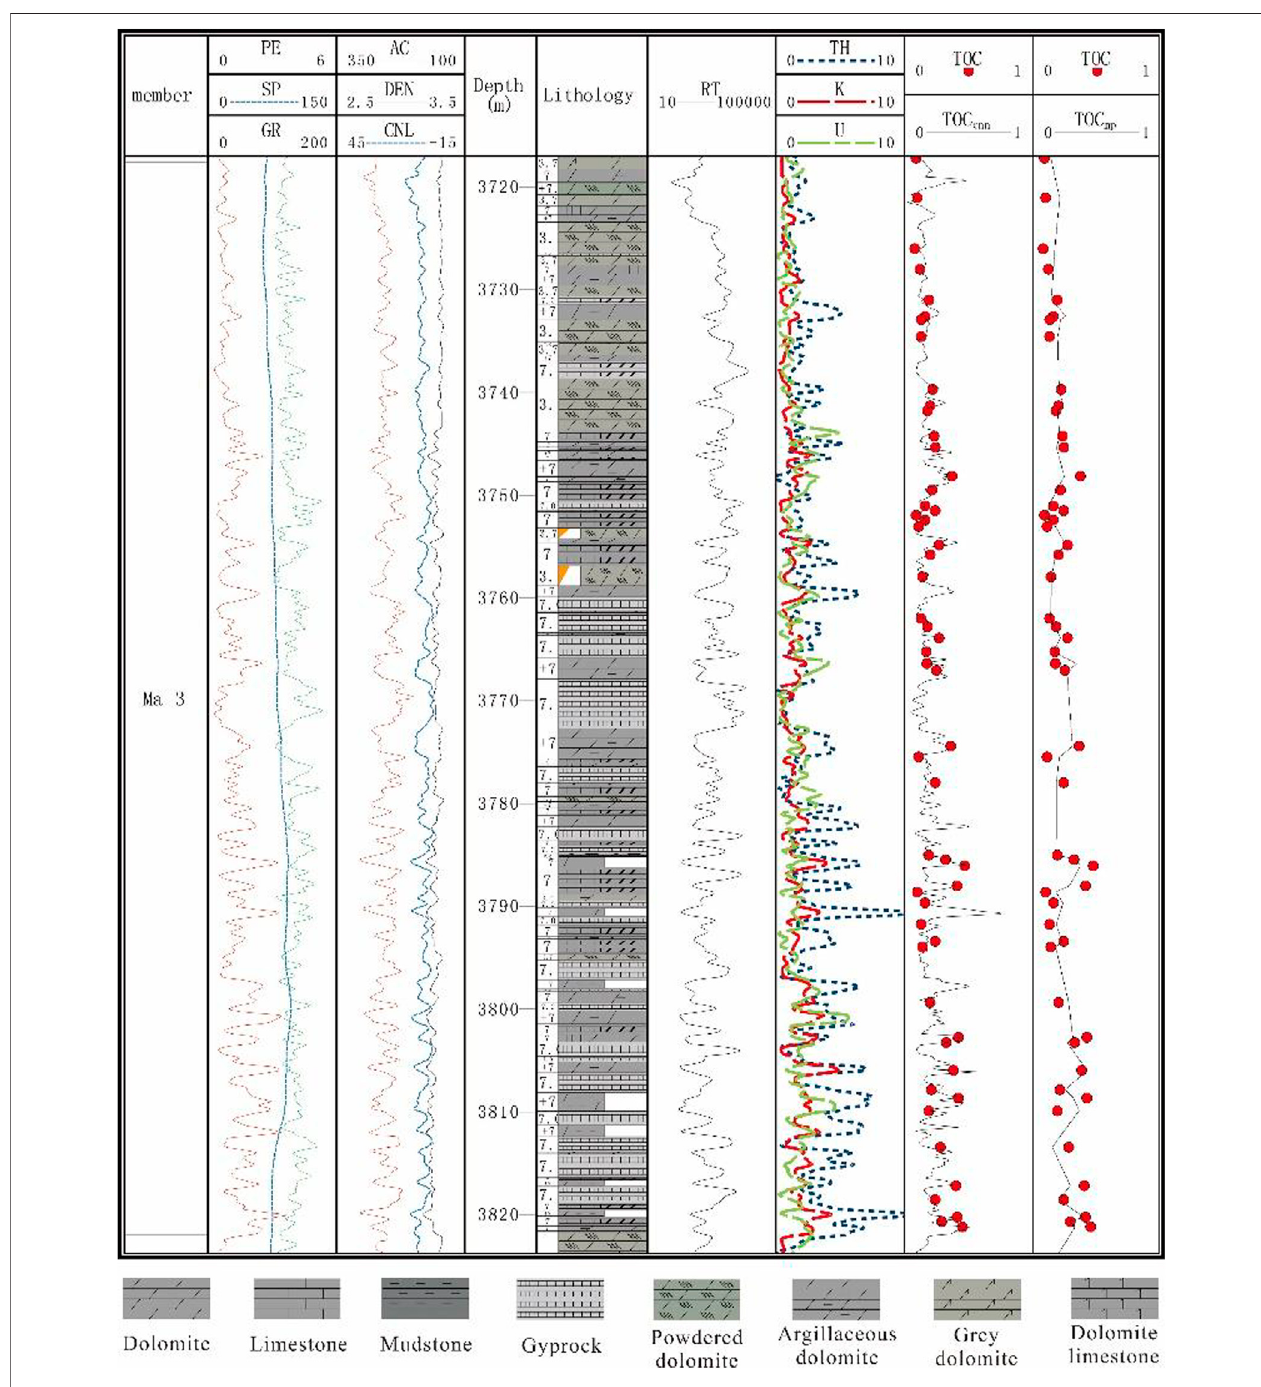
FIGURE 10 | TOC results of different models for well Tao